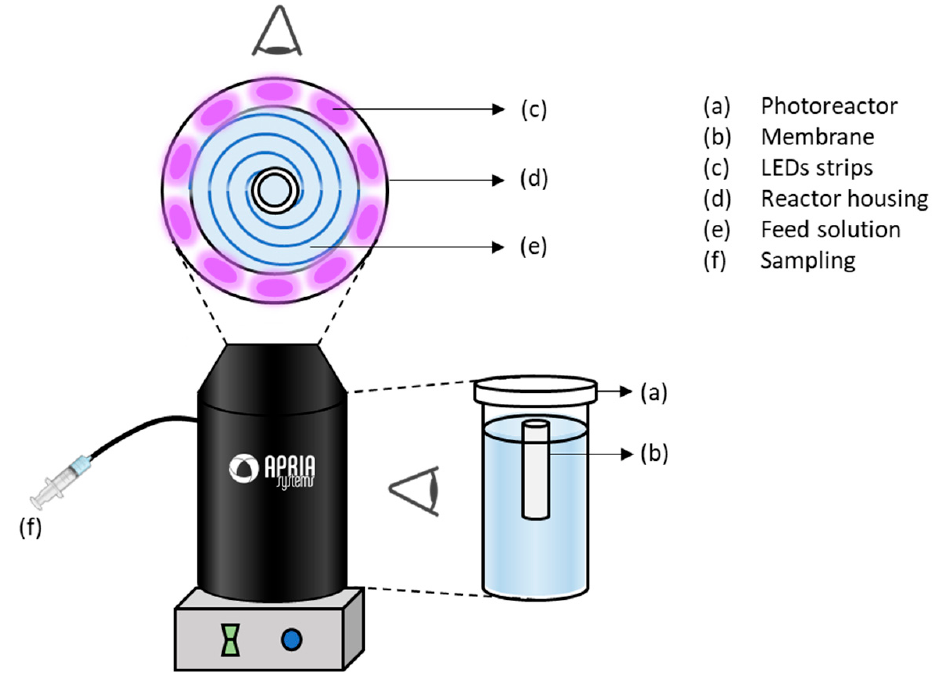
Figure 2. Schematics of the photocatalytic system.